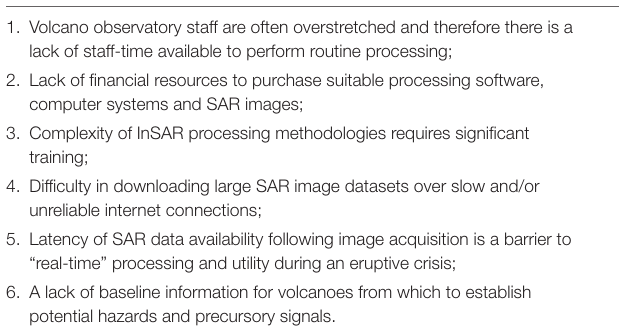
joint modeling procedure for incorporating processed InSAR